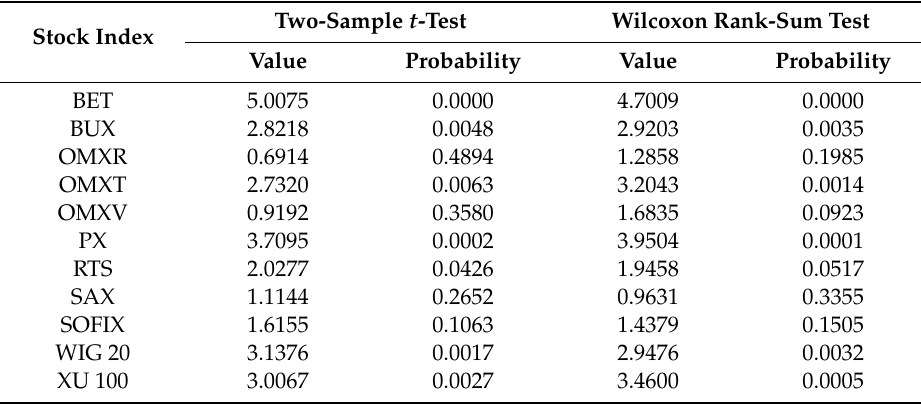
Table 2. Results of the statistical significance tests—Turn of the month window (1 + 1).